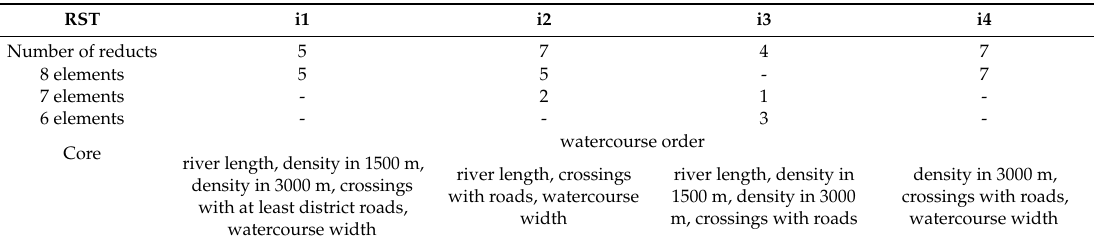
Table 14. Number, size, and cores of designated reducts designated using the RST method for the selection of sections of watercourses to the scale of 1:250,000.